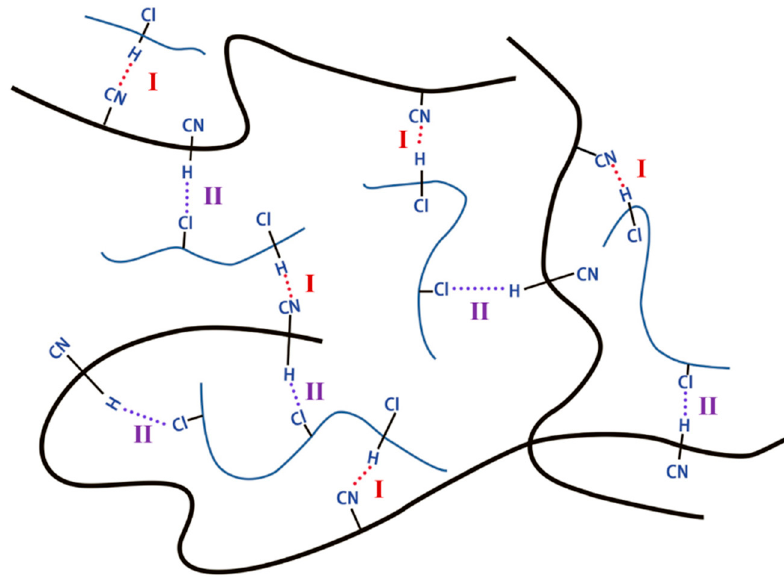
Figure 4. Schematic diagram of the CP52/NBR material network.